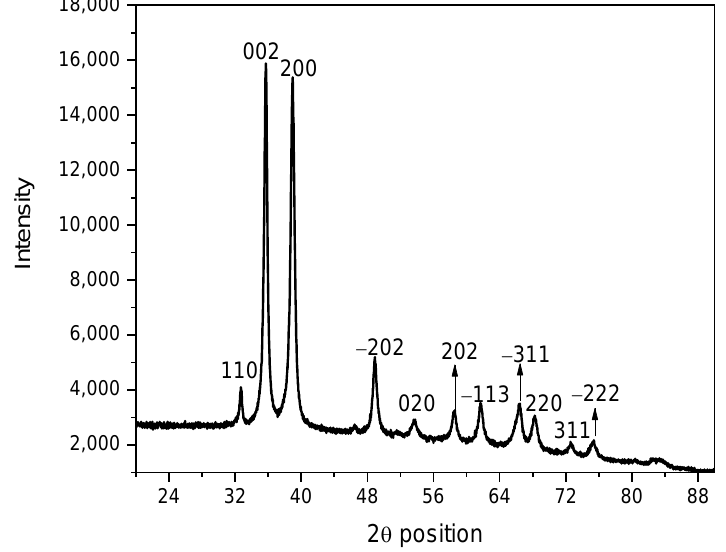
Figure 1. X-ray diffractogram of CuO NPs.